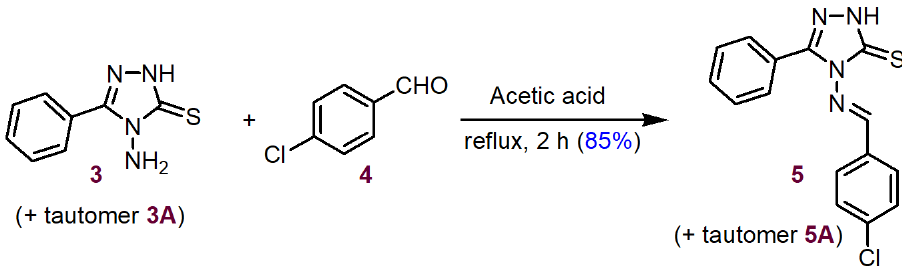
Figure 2. Spectroscopic characterization for 1,2,4-triazole 3